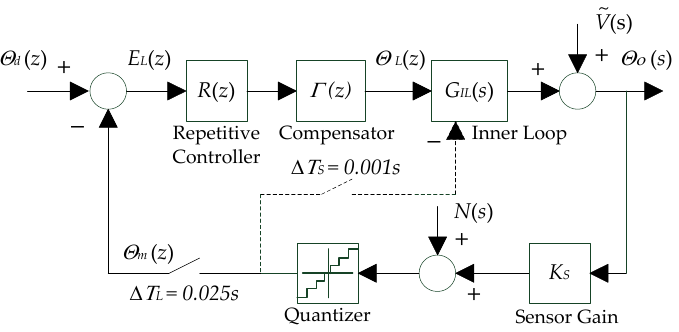
Figure 8. Block diagram of the outer-loop learning-based repetitive controller.